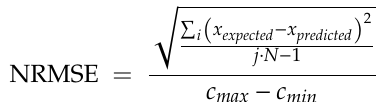
Table 3. Results of the fitted regression curves for obtained vs. expected values, for the training and testing subsets of samples and the three considered compounds (intervals calculated at the 95% confidence level). NRMSE: normalized root mean square error.